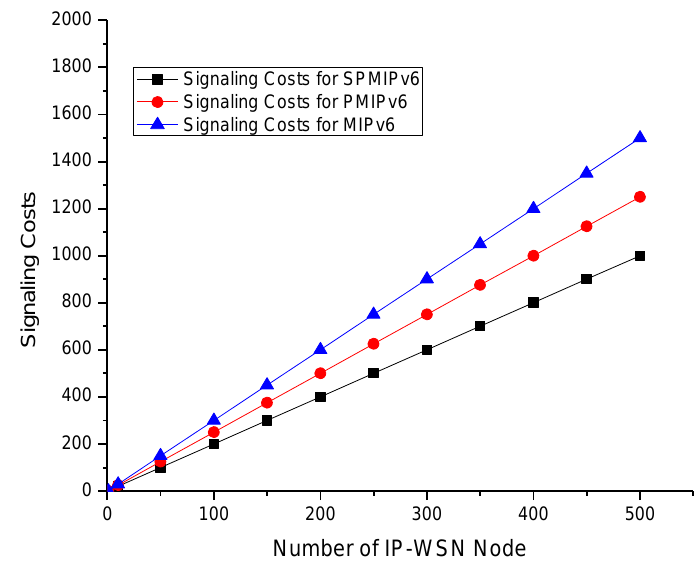
Figure 9. Number of IP-WSN nodes vs. Signaling